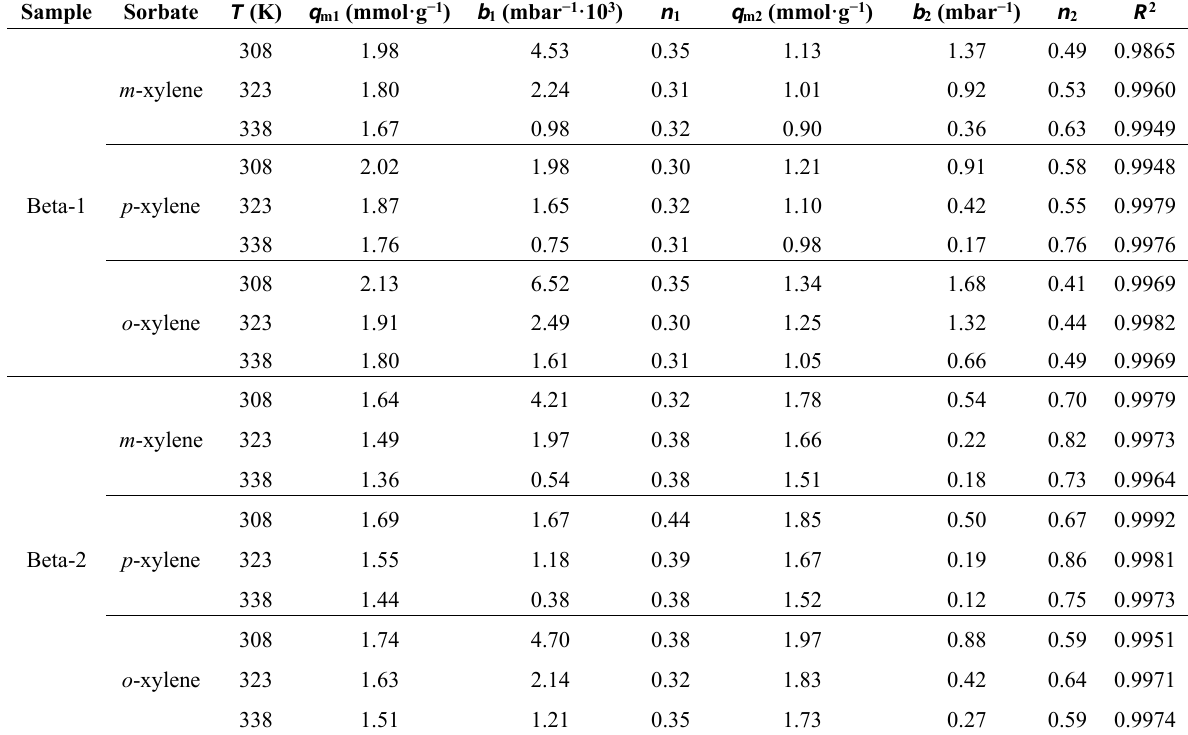
Table 3. Dual-site Toth fitting parameters of xylene isomers on Beta-1,-2,-3.